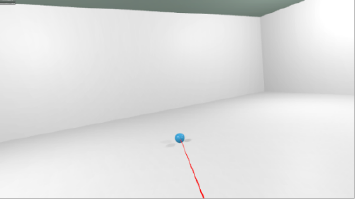
Figure 1. Using controllers to select the target sphere.